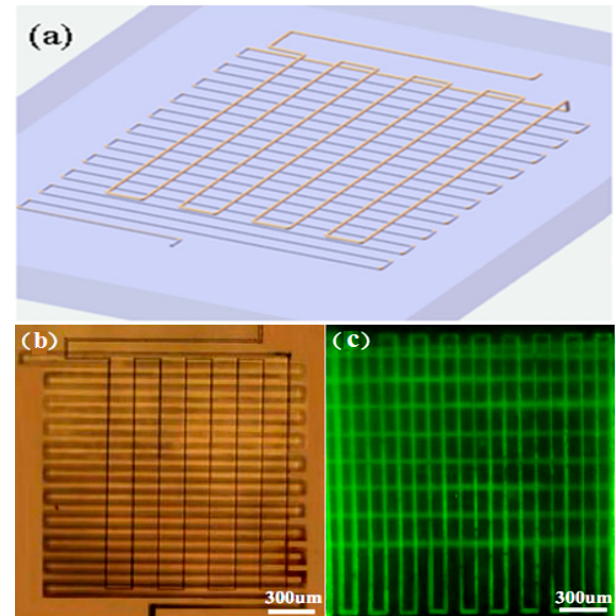
Figure 2. ( a ) Schematic diagrams of the 3D microchannel; and ( b ) optical micrograph of a 3D microchannel arranged in a compact space before the postannealing of the fabricated sample; ( c ) the fluorescence microscope image of the 3D microchannel filled with a solution of fluorescein. The volume of the substrate is reduced by ~39% as a result of the collapse of the nanopores.